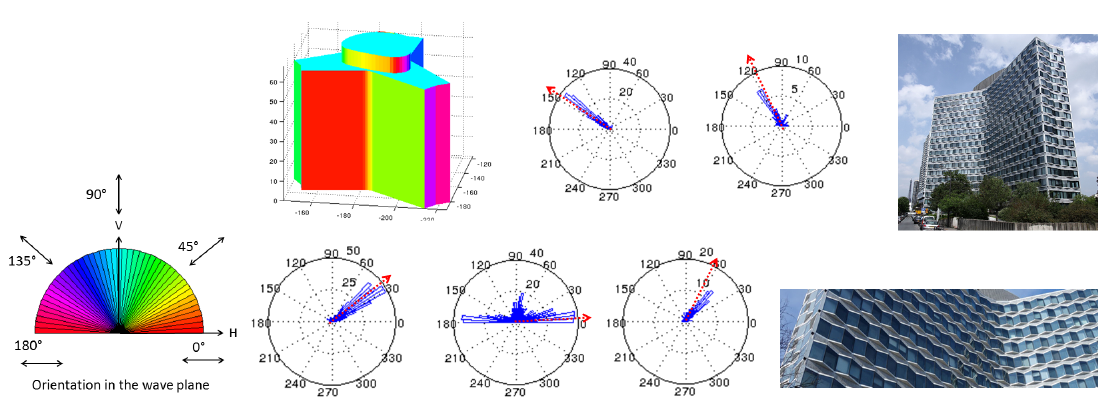
Figure 14. Results of estimation of polarimetric orientation for the Mirabeau